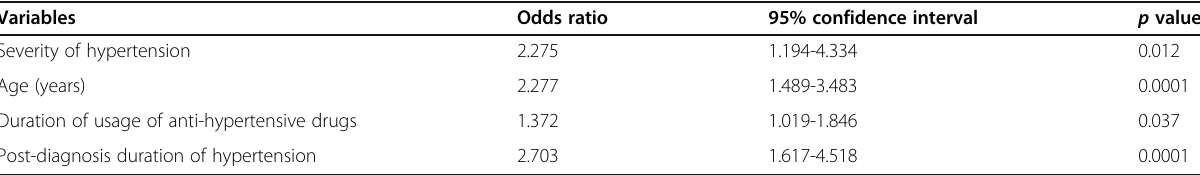
Table 5 Multivariate analysis of risk factors of hearing loss